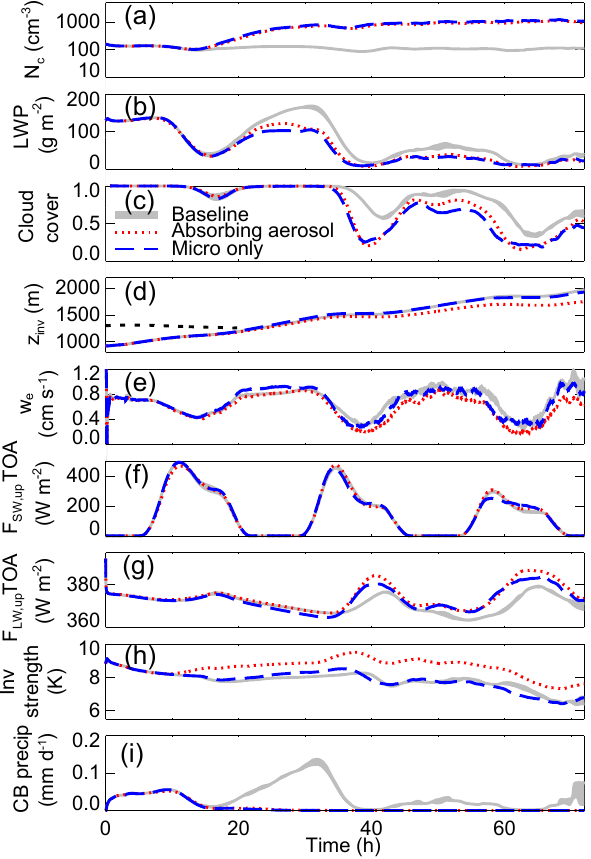
Figure 2. Evolution of domain averages of (a) cloud droplet num- ber concentration ( N c average weighted by cloud water mixing ra- tio), (b) liquid water path (LWP), (c) cloud cover (columns with LWP > 10gm − 2 ), (d) inversion height (height of maximum poten- tial temperature gradient), (e) entrainment rate (difference of in- version height tendency and subsidence rate at inversion height), (f) upwelling shortwave (SW) and (g) longwave (LW) radiative fluxes at TOA, (h) inversion strength ( (cid:49)T across inversion defined as the vertical extent with continuous positive temperature gradi- ent), and (i) precipitation rate at cloud base (mean over cloudy columns of lowermost height where the cloud water mixing ratio exceeds 0.01gkg − 1 ). Results shown as lagged 3h running averages to smooth entrainment rates. Range of the three-member lightly drizzling baseline ensemble ( N a , sulfate = 150mg − 1 ) in gray. Re- sults with the absorbing aerosol layer shown as red dotted line. Re- sults with the aerosol layer excluding radiative interaction shown as blue dashed line. The black dotted line in (d) indicates the base of the absorbing aerosol layer (lowest height where N a , absorb is full strength) before contacting the boundary